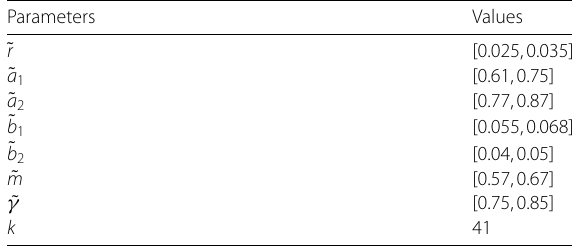
Table 11 The values of different parameters used to simulate the model system (3.8)